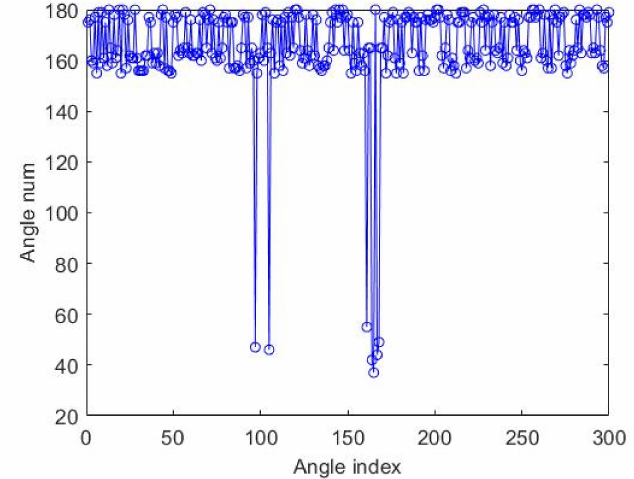
Figure 6. Angle distribution